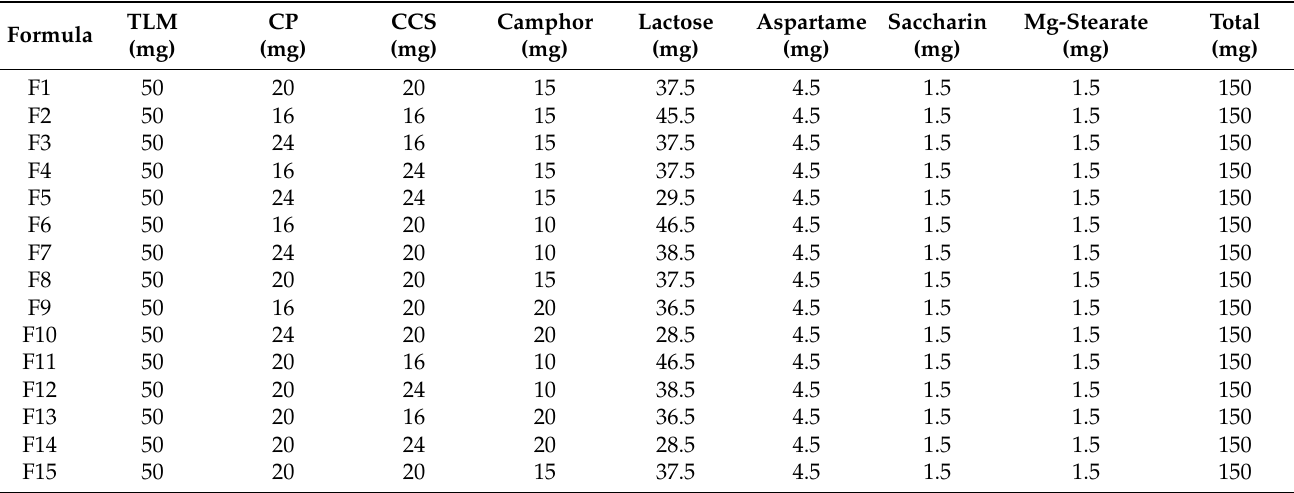
Table 1. Composition of different Tolmetin Fast Dissolving Tablet